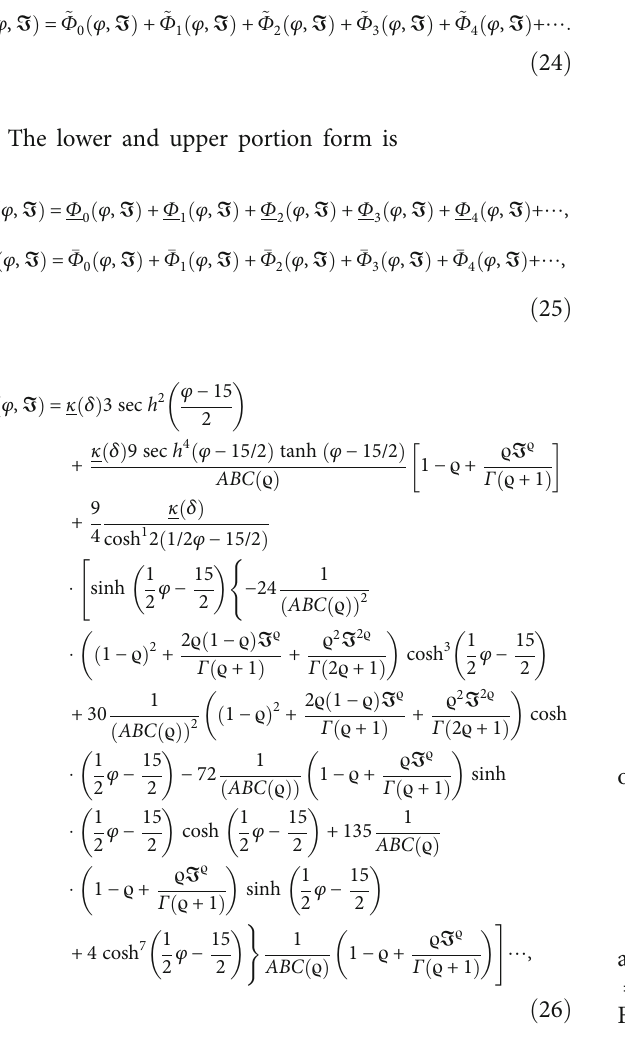
Figure 1: (a) The three-dimensional fuzzy upper and lower branch graph of approximate series result at ϱ = 1 and (b) at fractional-order of ϱ = 0 : 8